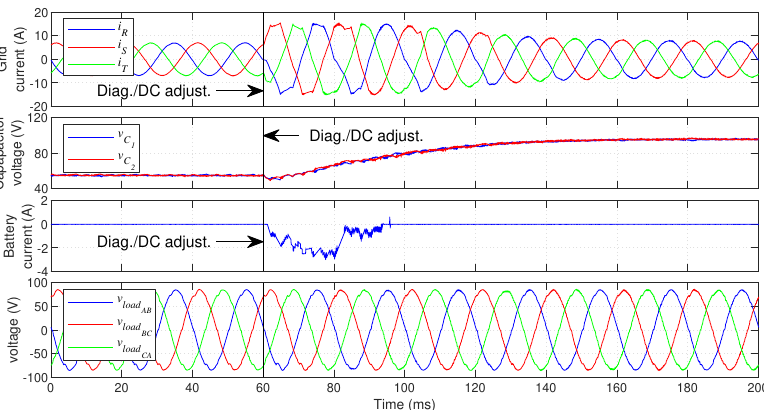
Figure 15. Normal and fault-tolerant UPS operation when an OC occurs in outer IGBT S R 1 of the GSC. The advantages of the proposed technique in steady-state are shown in Figure 16.